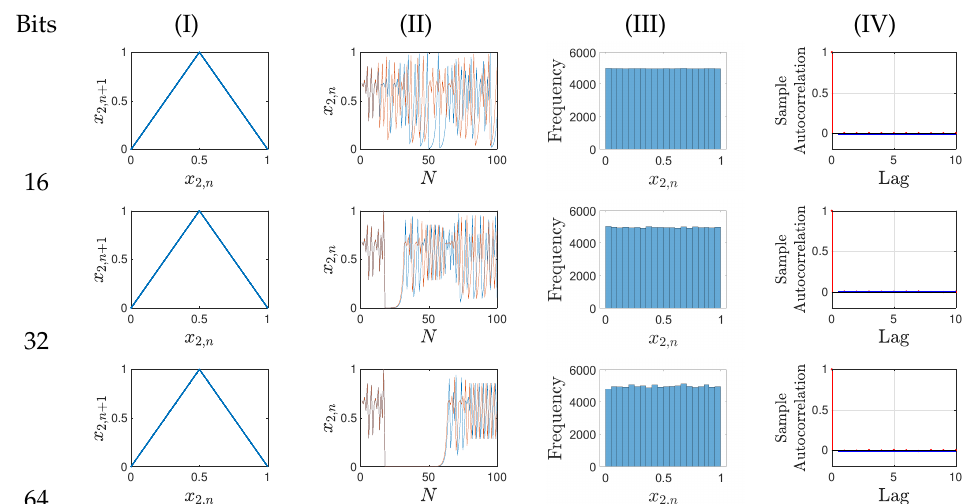
Figure 3. The results achieved by the proposed chaotic circuit and perturbation method. Column (I) shows the return map. Column (II) shows two chaotic time series with initial conditions x 2,0 (blue line) and x 2,0 + ulp (brown line), respectively. The x-axis is the number of iterations ( N ) and the y-axis is the decimal converted value of the digital chaotic system— x 2, n . Ultimately, columns (III) and (IV) show the histogram and the autocorrelation function, respectively.